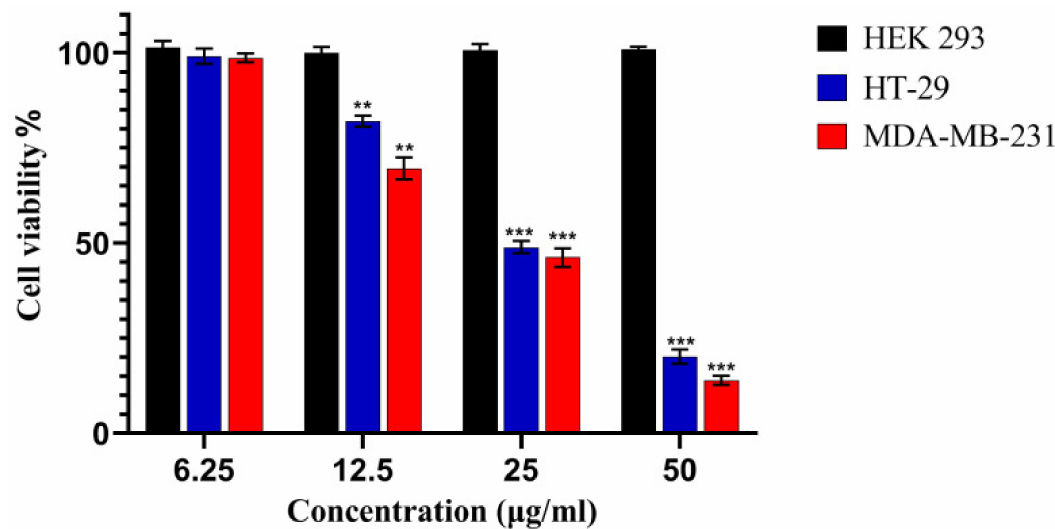
Figure 9. Assessment of the inhibition of cell proliferation by MTT assay. The cell lines were treated by serially diluted concentrations of leptulipin for 24 h. The maximum inhibition of cell proliferation was seen at 50 µ g/mL. N = 3, p < 0.01 (**) and p < 0.001 (***).